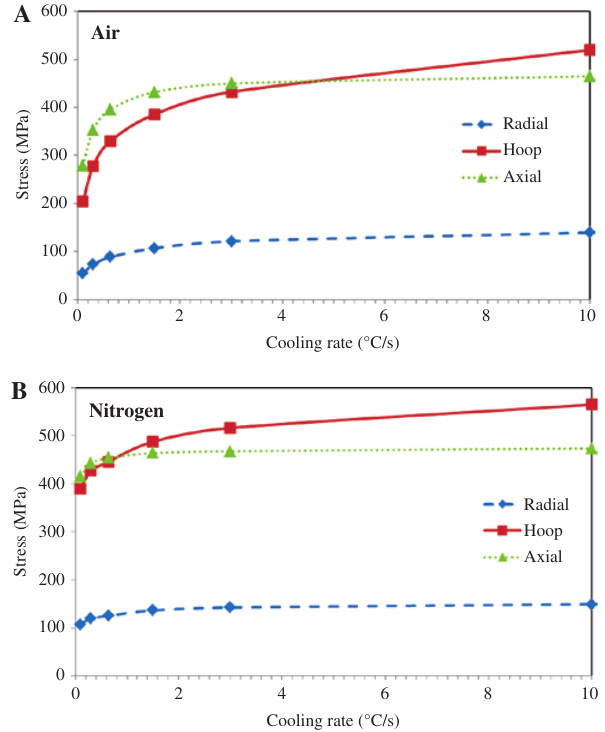
Figure 4: Variation of maximum axial, hoop, and radial stresses in the matrix in (A) air and (B) nitrogen environments as a function of cooling rate with FVF = 32%.